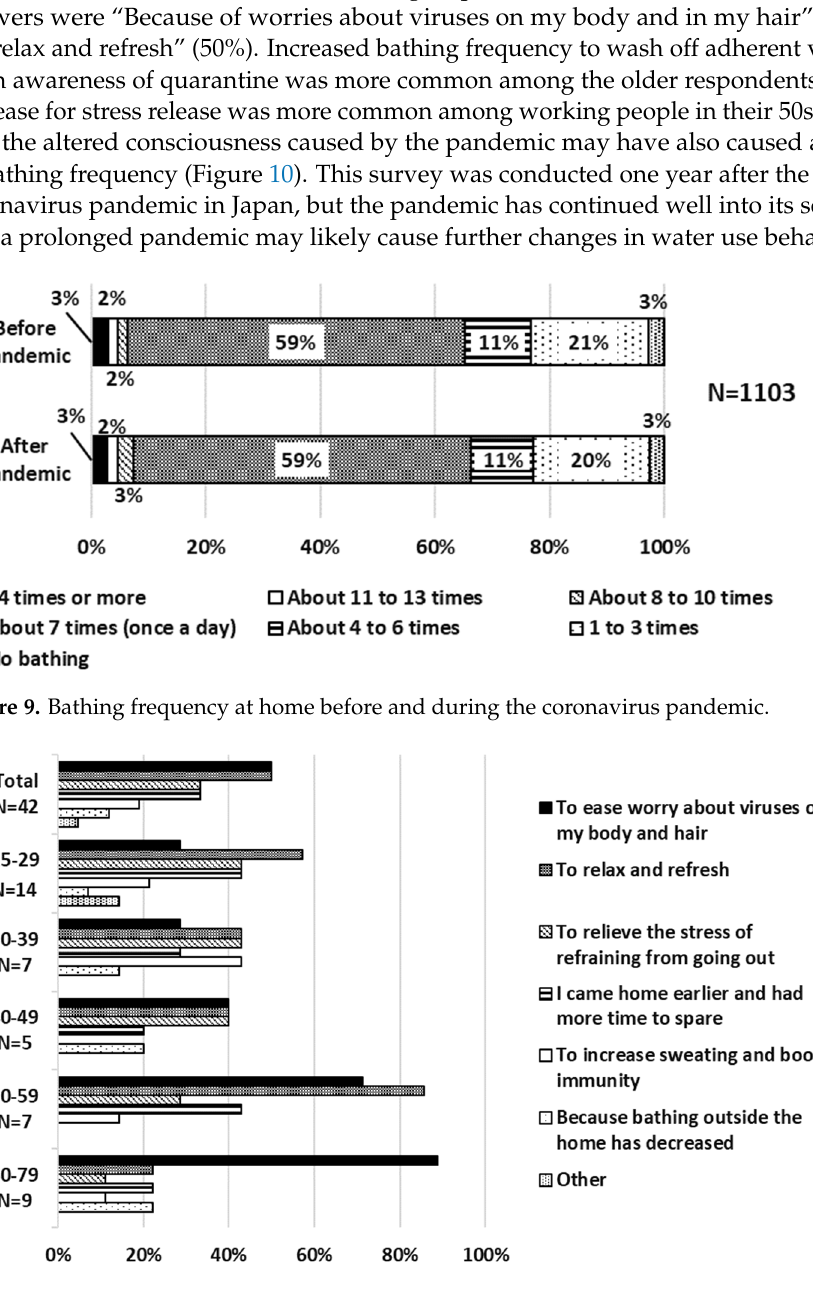
Figure 11. Changes in water usage in the kitchen.